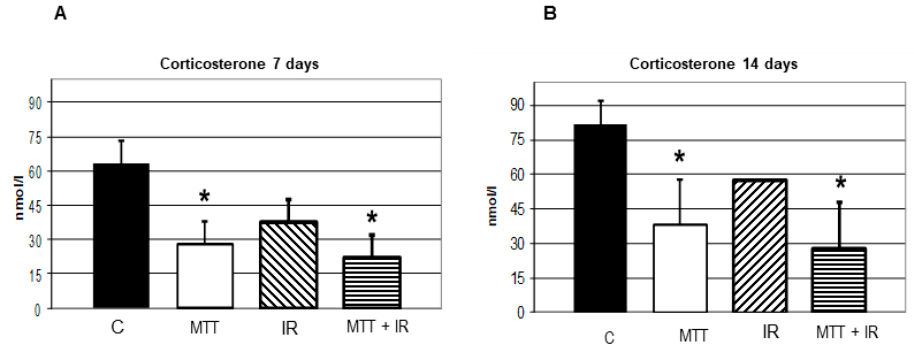
Figure 3. Effect of the treatments on steroidogenesis. Hormonal assays at 7 days after treatment ( A ) and at 14 days after treatment ( B ). The corticosterone levels in both groups of mice treated with the drug alone and in combination with IR are significantly lower than those from the untreated control ( p < 0.005) at 7 and 14 days after treatment, respectively. The treatment with IR alone does not significantly affect the corticosterone level ( p < 0.08). The combined IR/MTT treatment increases the inhibitory effect on the corticosterone level at 7 ( p < 0.001) and 14 ( p < 0.001) days after treatment.